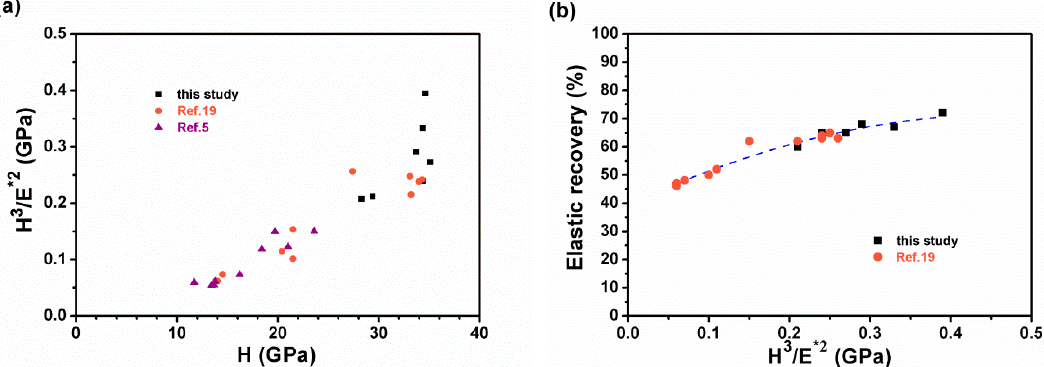
Figure 11. ( a ) H 3 /E *2 ( E * : effective Young’s modulus) as a function of hardness ( H ) and ( b ) elastic recovery ( We ) as a function of H 3 /E *2 for Zr–Si–N films. ( ● : reference 19; ▲ : reference 5).